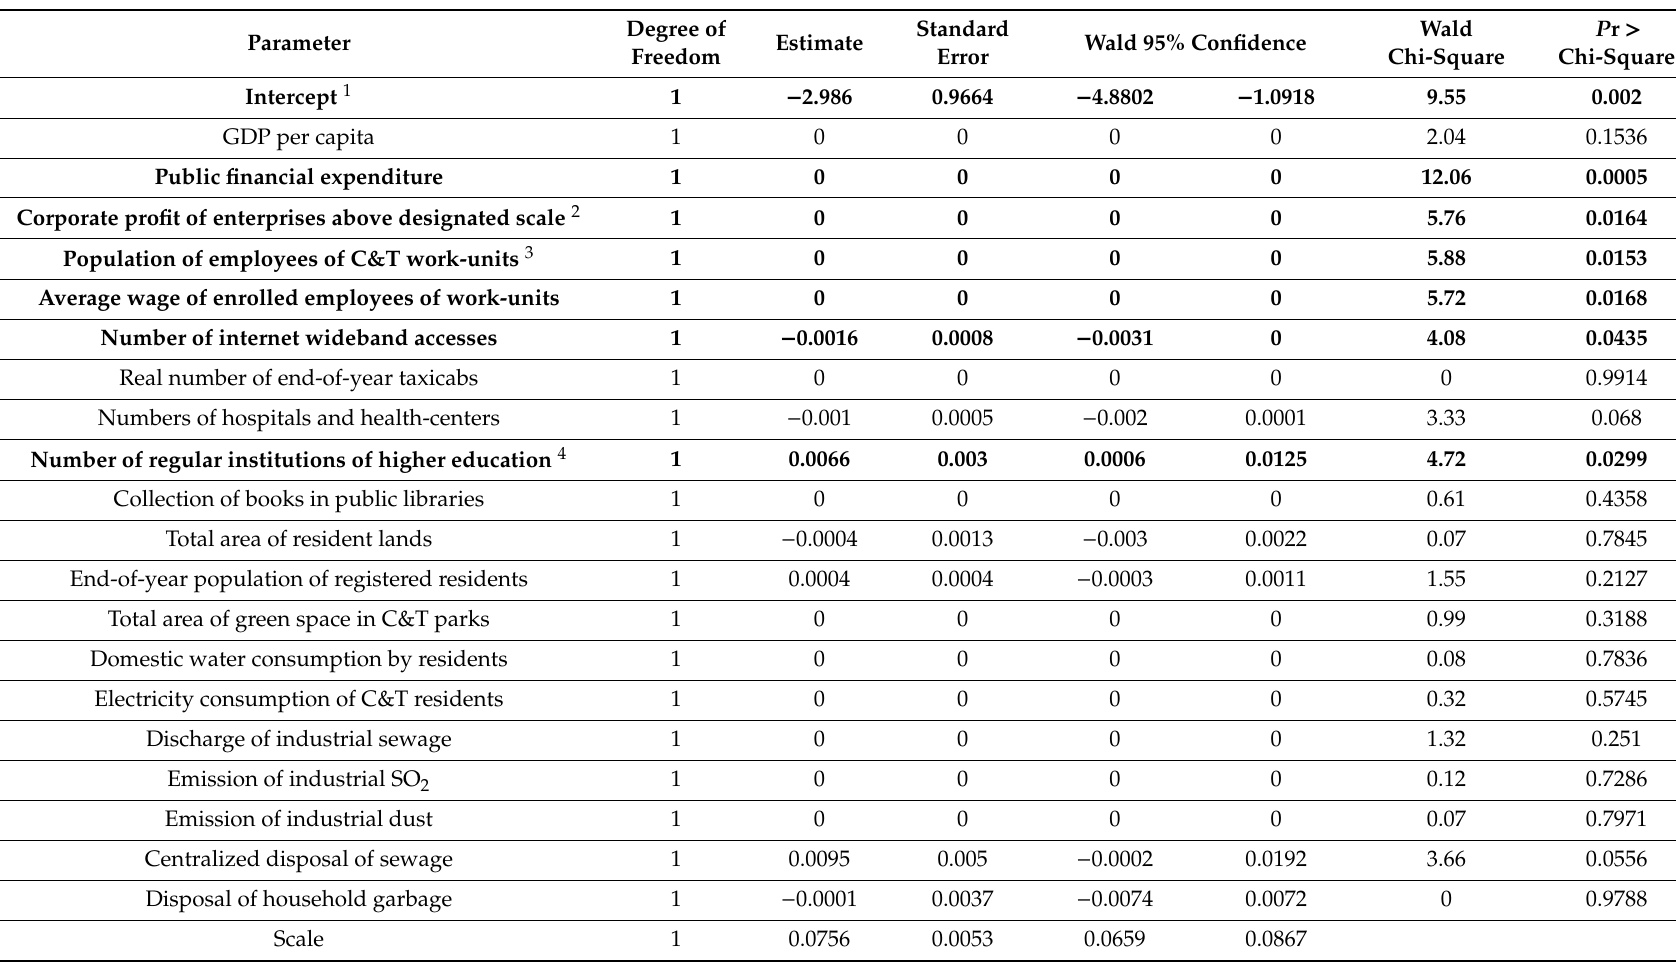
Table 4. Maximum likelihood estimation of multiple city variables on happy expression scores of students from key universities of cities across mainland of